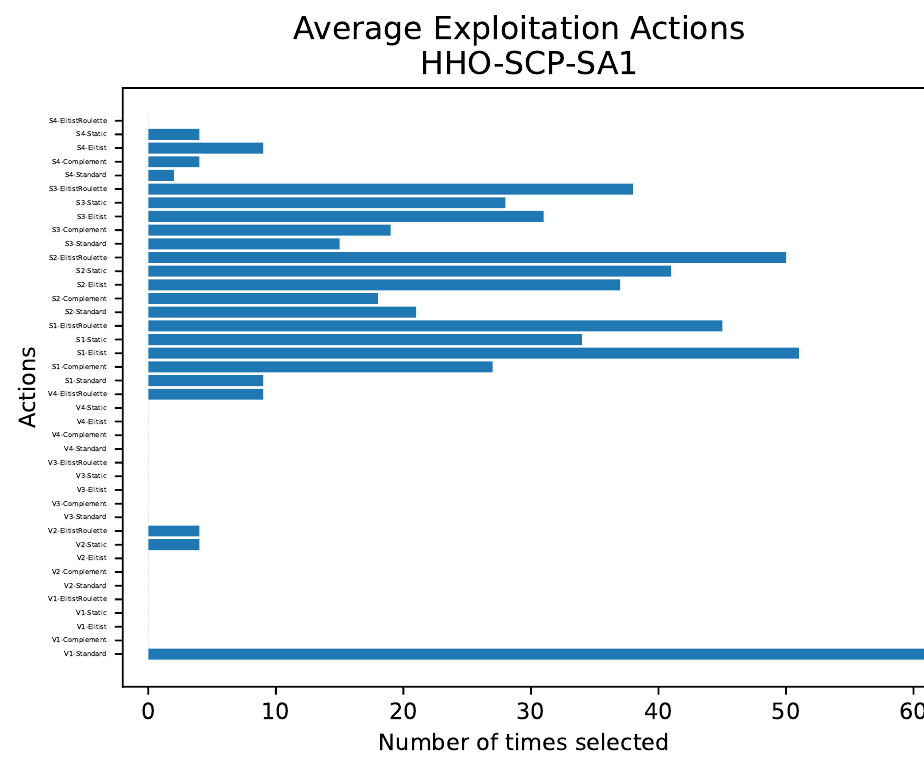
Figure 12. HHO-SA1—The average number of actions in the exploitation state.